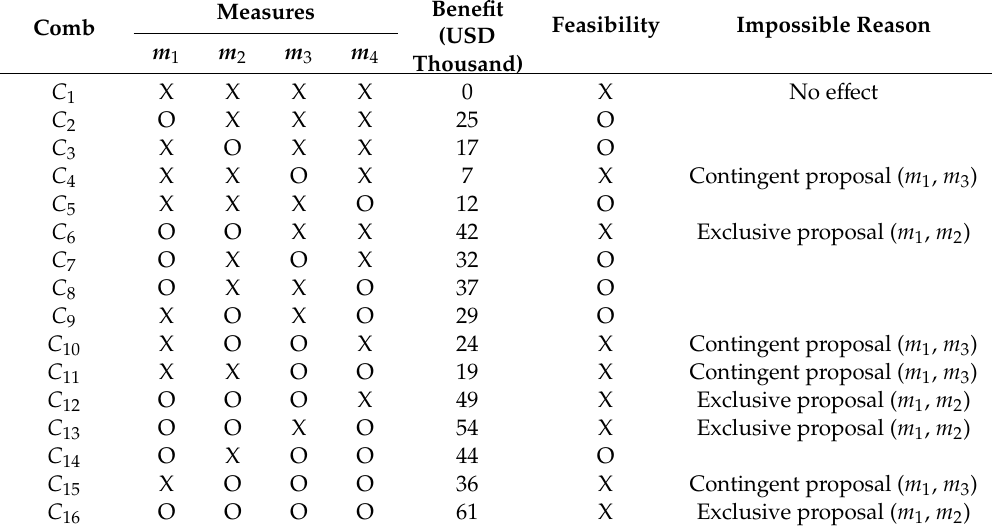
Table 2. Determination of proper combinations using